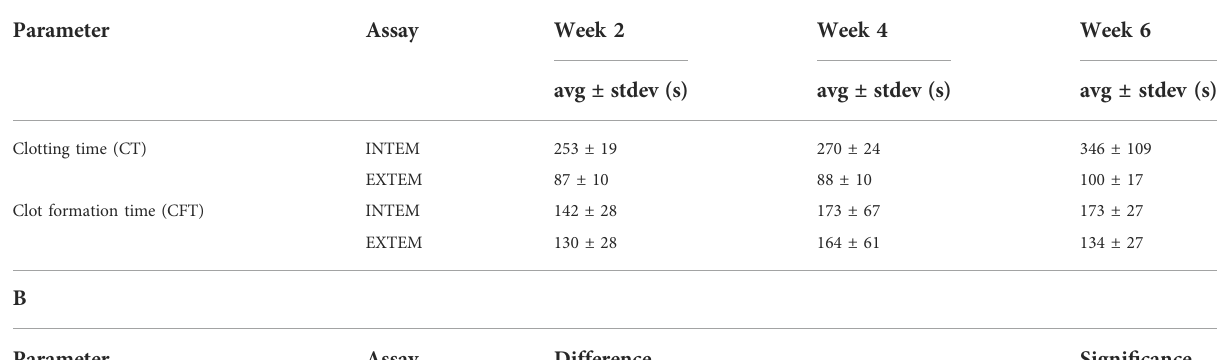
TABLE 1 Storage time-dependent change in coagulation characteristics in blood samples reconstituted with